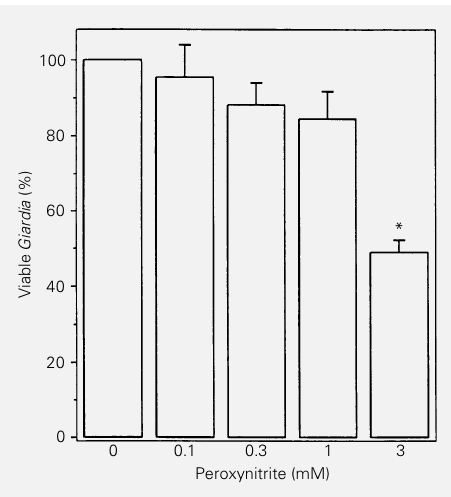
Figure 4 - Effects of SNAP, xan- thine/xanthine oxidase (X/XO) system or both on Giardia tro- phozoite killing (open bars) and nitrite accumulation (shaded bars). Trophozoites were incu- bated either with SNAP (200 (cid:181)M), xanthine (1mM)/xanthine oxidase (20 mU/ml) or both for 2 h at 37 o C. Results are reported as means – SD of triplicates. *P<0.05 when compared to the effects of SNAP alone (analysis of variance followed by the Bonferroni t -test). The same re- sults were obtained in two ex- periments. C, Control.